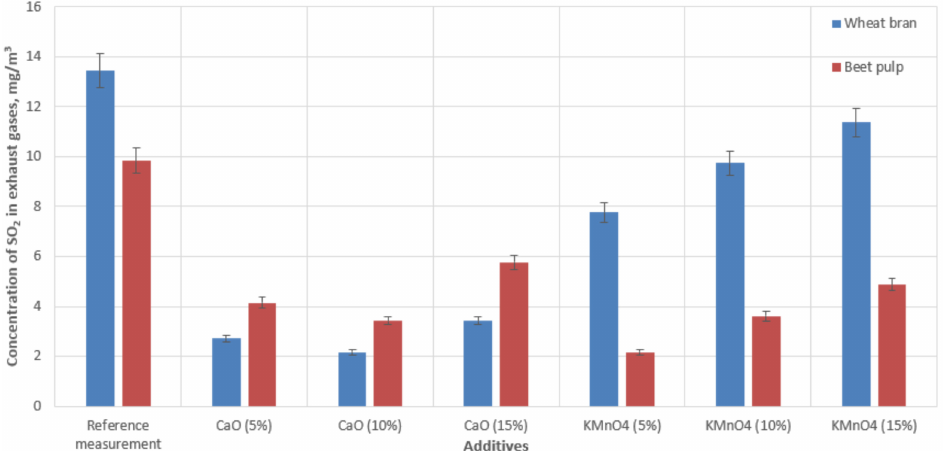
Figure 6. Concentrations of sulfur oxides in the flue gas of a low-power boiler during the process of burning biomass with catalytic additives.